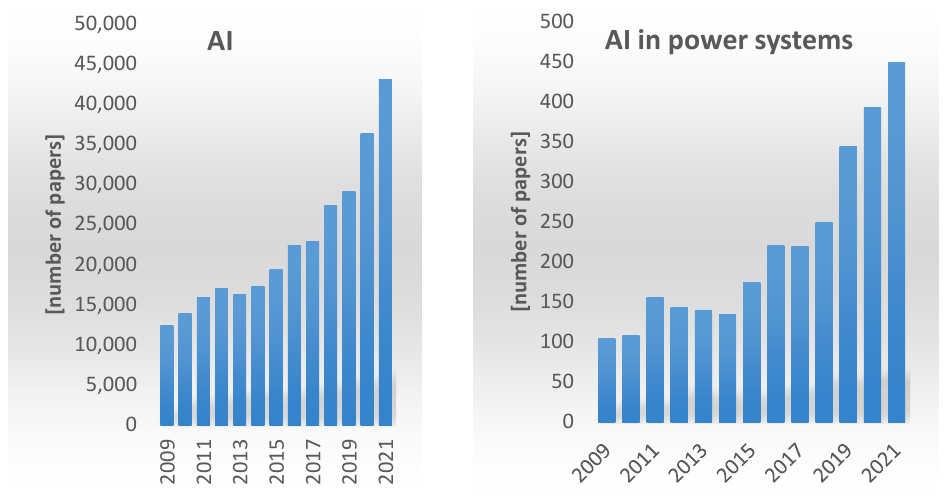
Figure 1. Research papers on AI (left) and AI in the power system